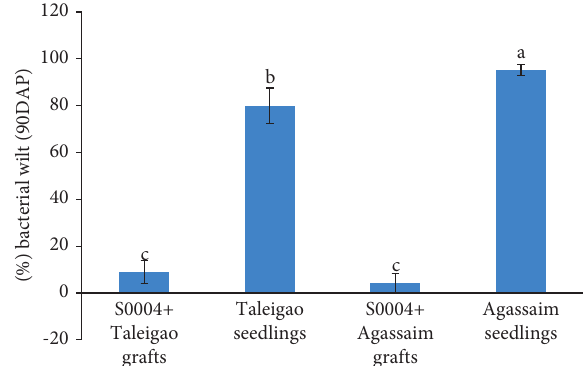
Figure 2: Incidence of bacterial wilt in eggplant grafts on S0004 and nongrafted seedlings in the field evaluation at research farm of ICAR- CCARI (March 2016). S0004+ Taleigao grafts: mean of 6 replications; mean No. of plants per replication: 7.5; Taleigao seedlings: mean of 8 replications; mean No. of plants per replication: 9.75; S0004+ Agassaim grafts: mean of 6 replications; mean No. of plants per replication: 8.0; Agassaim seedlings: mean of 10 replications; mean No. of plants per replication: 13.8; bar in the column represents the standard error. Treatments are significantly different at 5% (LSD � 12.69). Wilt % in the column indicated by the same letter are not significantly different at 5% level.